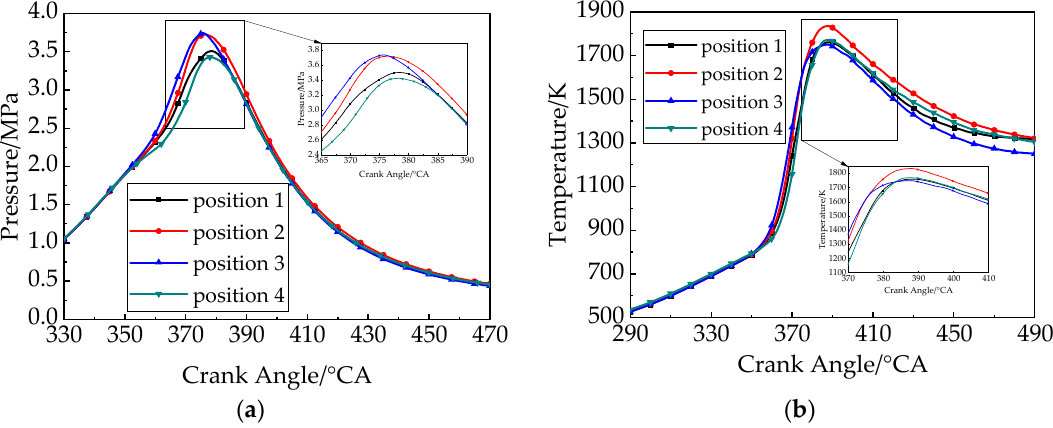
Figure 11. Comparison of in-cylinder mean pressure and temperature at different positions: ( a ) pres- sure, ( b ) temperature.